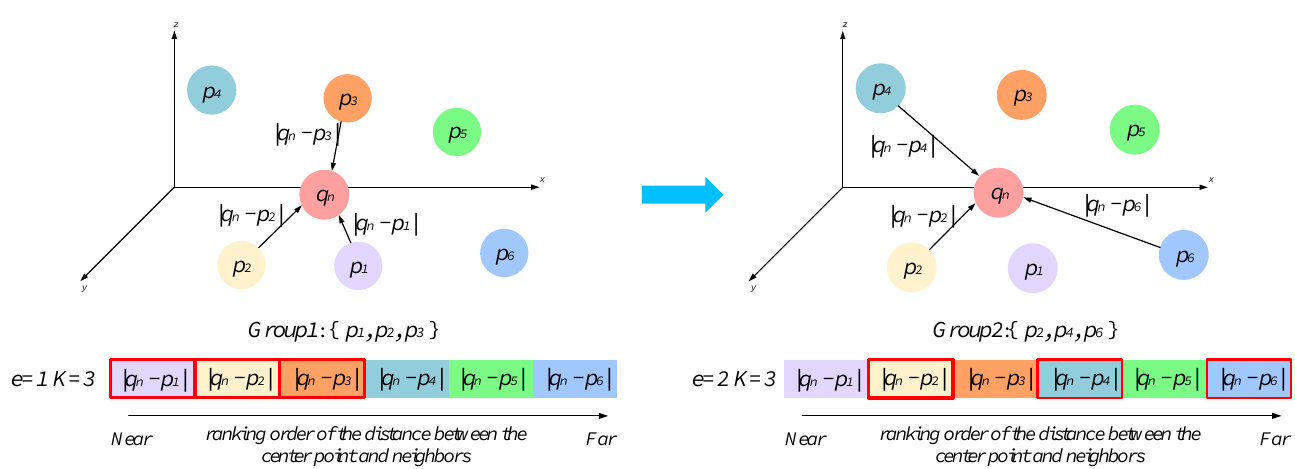
Figure 2. Working principle of PEG unit. p i ( i = 1,2,3,4,5,6 ) denotes the i th nearest neighboring point feature of the centroid q n . The red boxes indicate the selected point